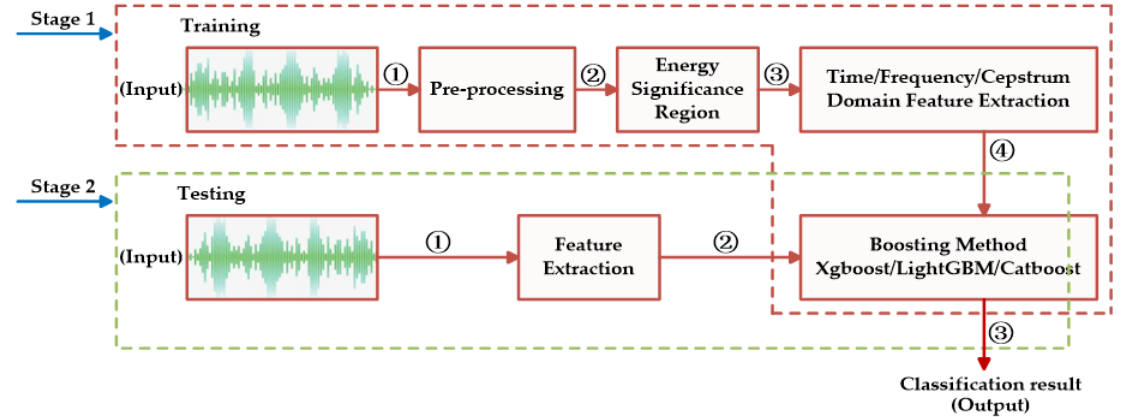
Figure 5. The feature extraction and classification process. The numbers given in the figure are the signal processing steps during the training and testing stages. signal processing steps during the training and testing